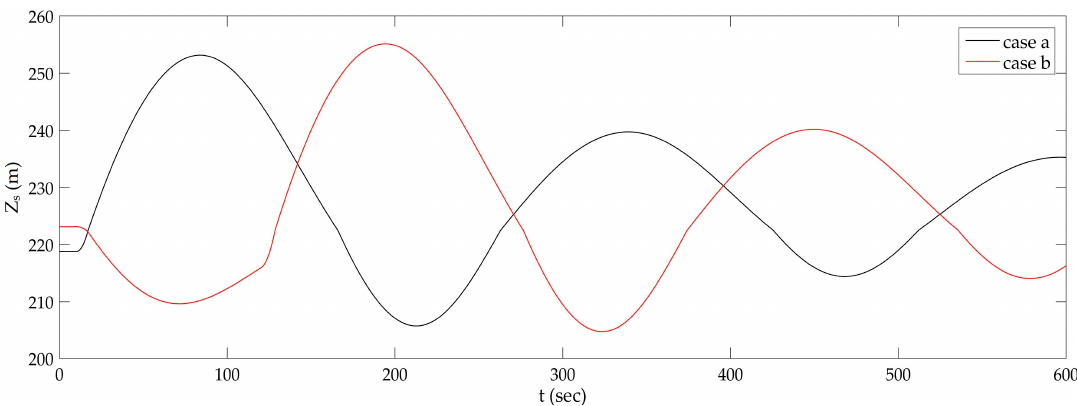
Figure 6. Water level in the surge tank for different cases of upsurge described in Section 2.5.1.